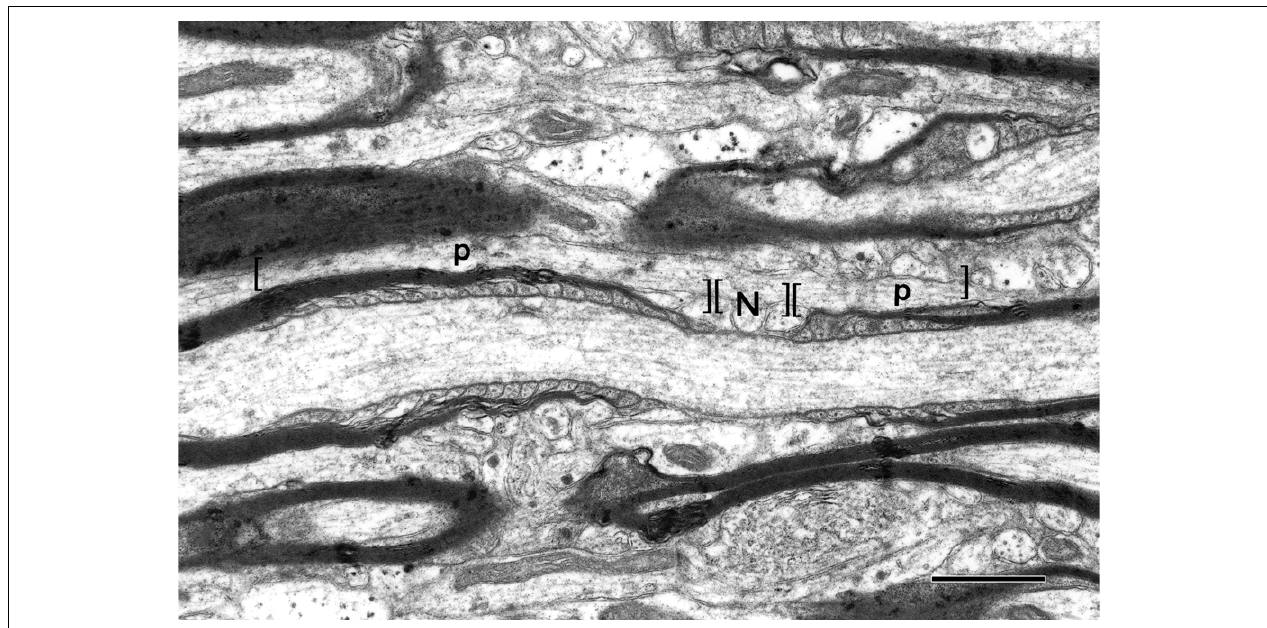
FIGURE 1 | A longitudinal section of a myelinated nerve fi ber in primary visual cortex of a rhesus monkey. The section passes through a node of Ranvier (N) where the axolemma has a characteristic undercoating. On each side